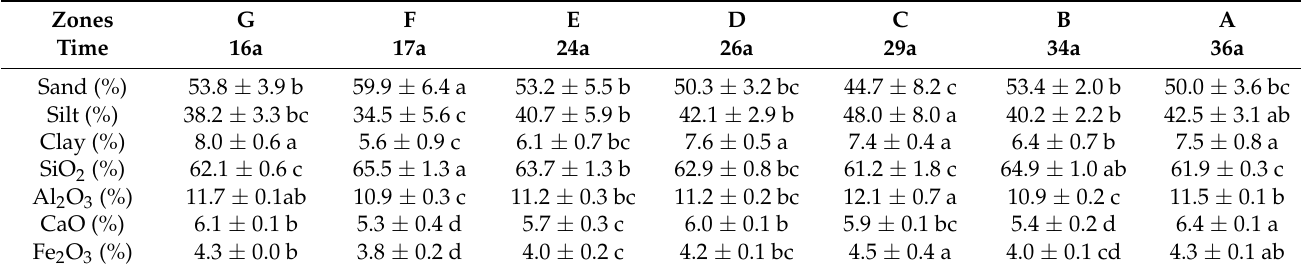
Note: The soil particle sizes of clay, silt and sand are < 0.002 mm, 0.002–0.05 mm, and 0.05–2 mm, respectively